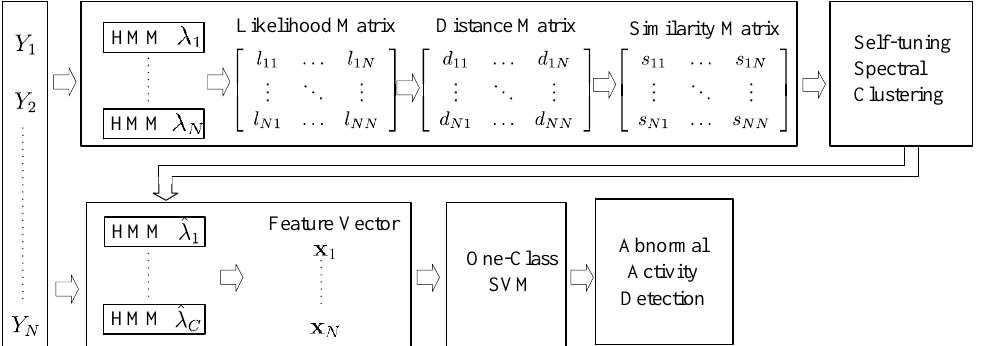
Figure 3. A block diagram illustrating our